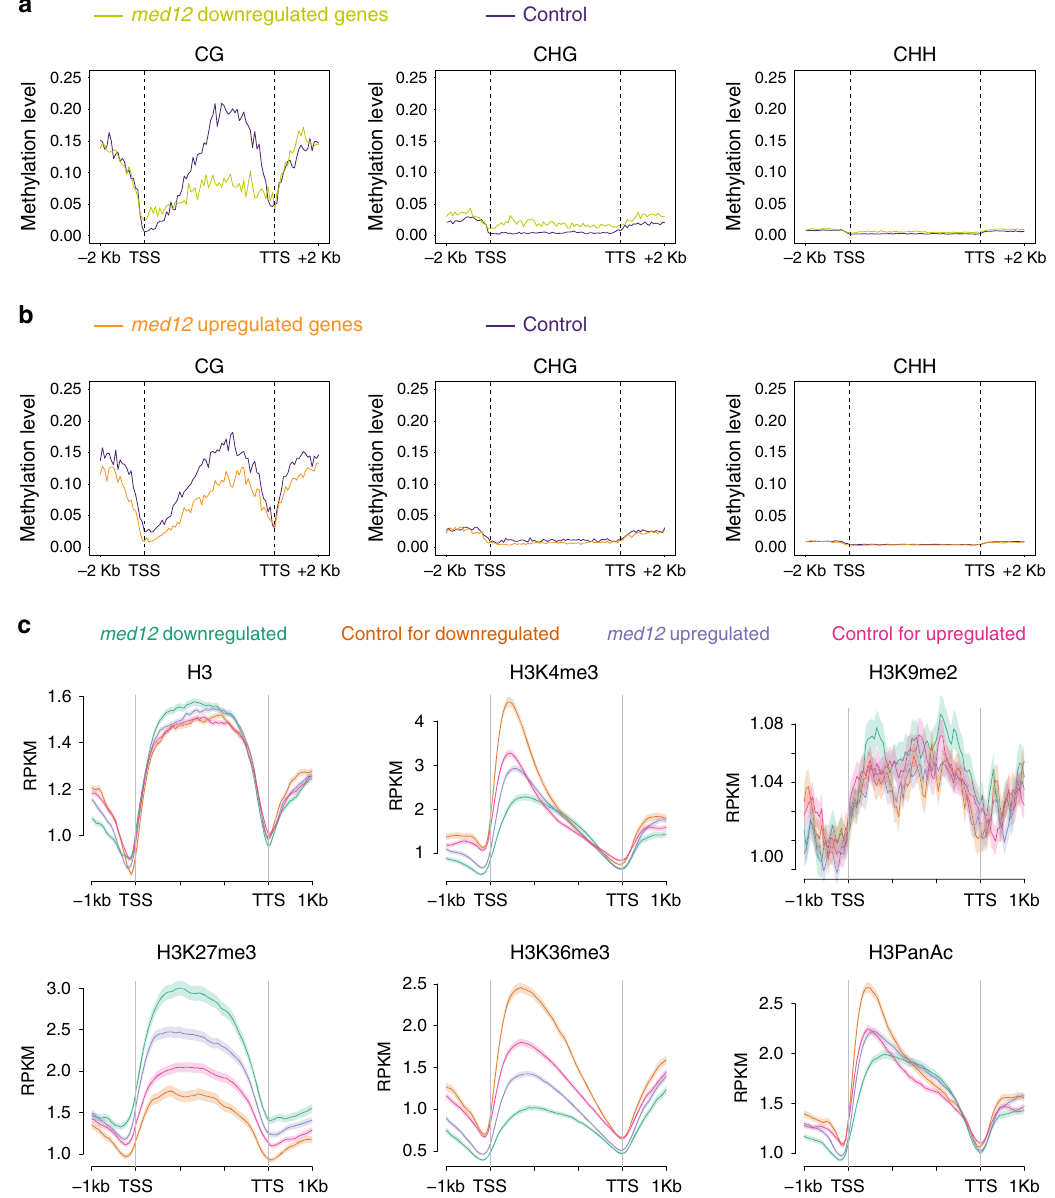
Fig. 3 Characterization of epigenetic features of med12 differentially regulated genes. a Average distribution of DNA methylations over med12 downregulated genes in three different sequence contexts (left to right, CG, CHG, and CHH). Control represents a group of randomly selected MED12 non- DEGs of similar expression levels. − 2 kb and + 2 kb represent 2 kb upstream of transcription start site (TSS) and 2 kb downstream of transcription termination site (TTS), respectively. b Same as in a , except for med12 upregulated genes. c Average distribution of histone modi fi cations over med12 DEGs, distinguishing genes downregulated (green) and upregulated (purple) in med12 from corresponding controls of similar expression levels (orange and pink, respectively). Top row from left to right, H3, H3K4me3, H3K9me2; Bottom row from left to right, H3K27me3, H3K36me3, H3PanAc. Shaded area represents the standard error (SEM) centered on mean value (dark solid lines). n = 3 biologically independent